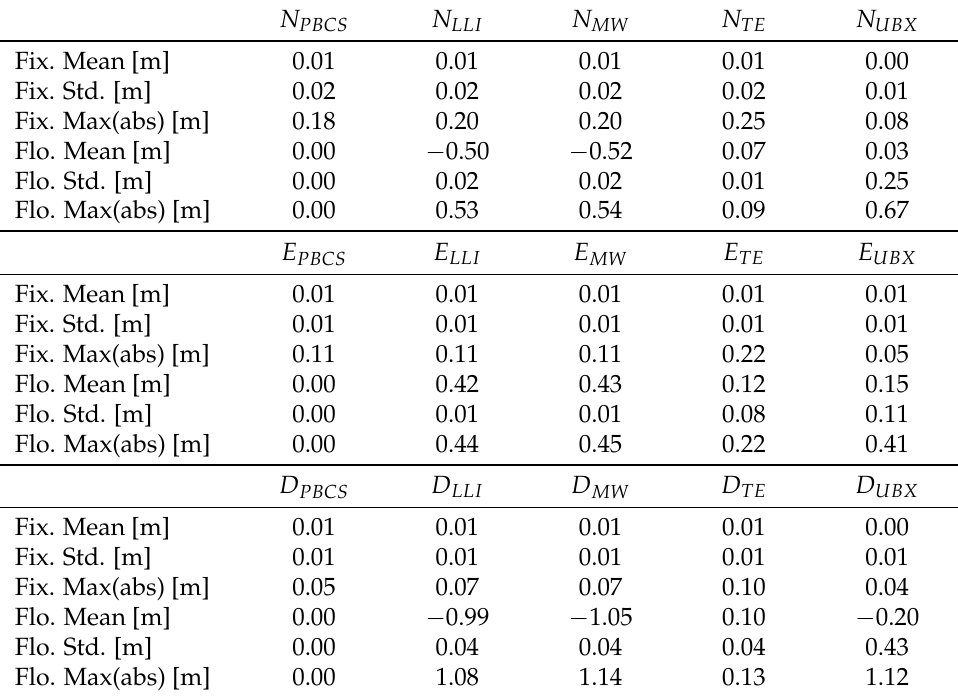
Table 3. Coordinate difference statistics from KVH GEO-FOG 3D—Case Study 1.